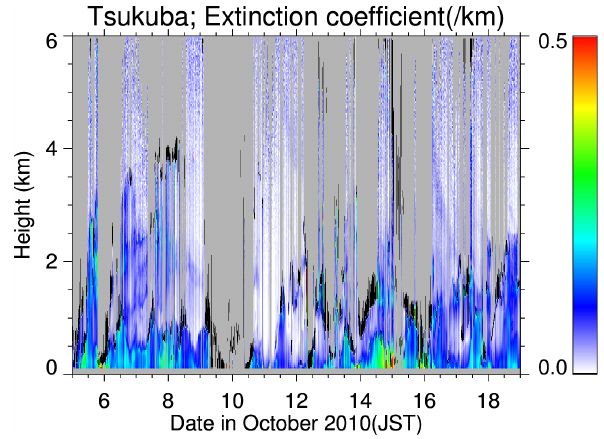
Figure 2. Vertical profiles of AEC values at 532nm derived from lidar observations. Black indicates the regions between the cloud base and apparent cloud top. Gray corresponds to invisible regions above clouds.